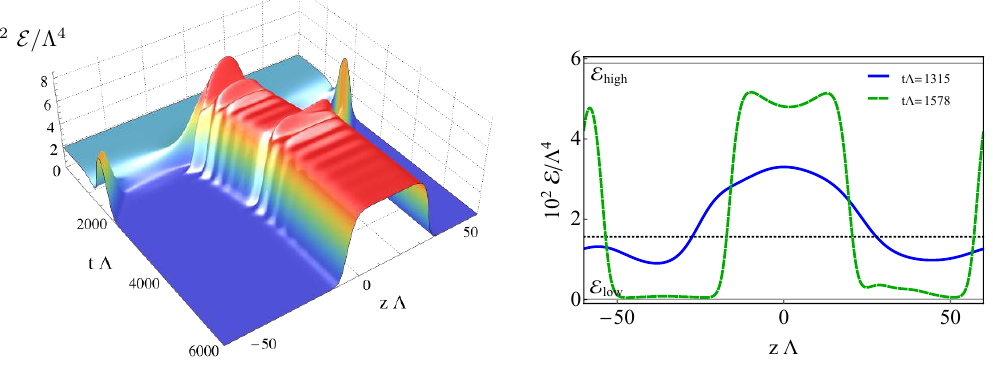
Figure 9 . (Left) Energy density of the evolution of an initial state with E ( t = 0) = E 2 ; L (cid:3) ’ 120. The central structure formed after the reshaping period is a phase domain. (Right) Snapshots of the energy density of the plot on the left at the end of the linear regime (solid blue) and at the end of reshaping period (dashed green).